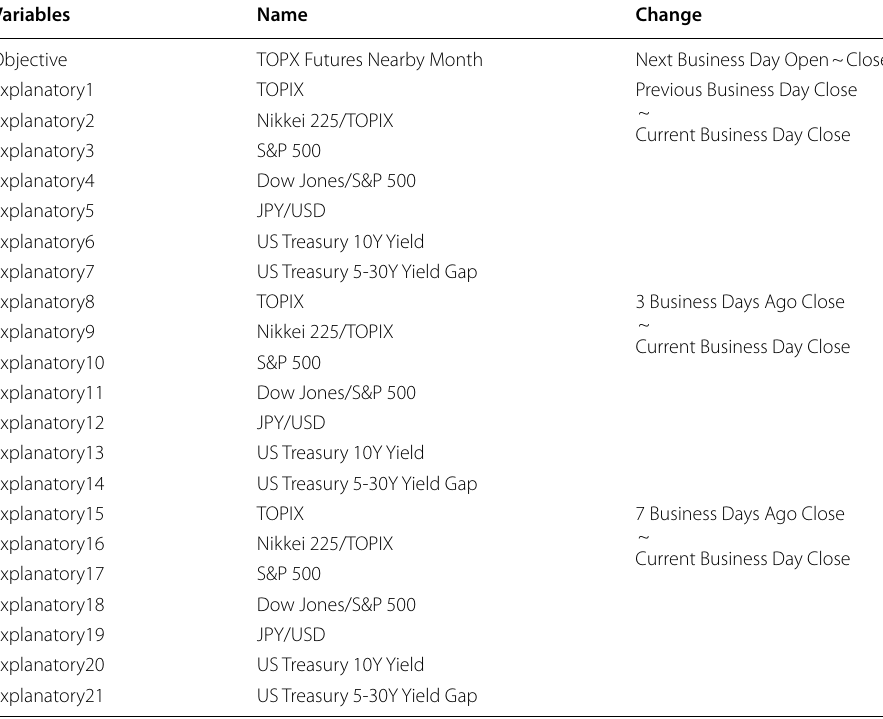
Table 2 Financial data used to predict TOPIX Futures in next business day